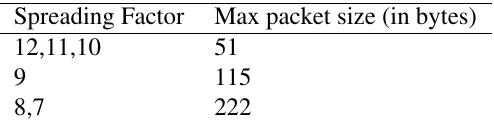
Table 1. Max packet size per SF for LoRaWAN